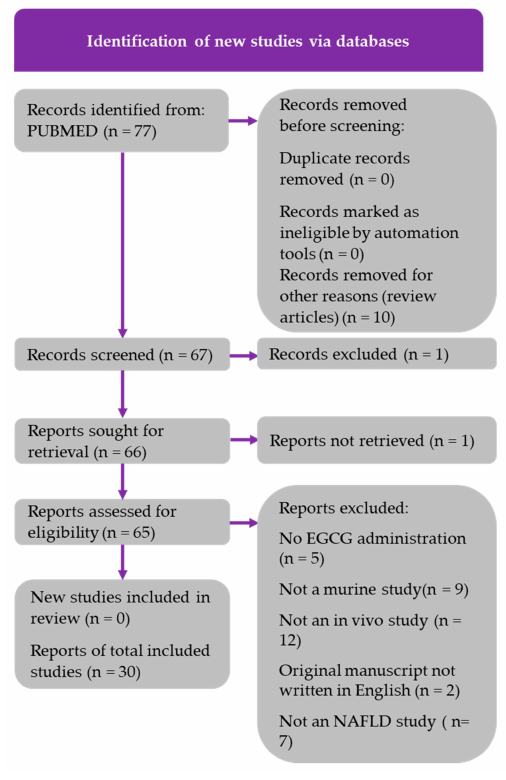
Figure 1. PRISMA flow chart for murine studies, indicating how the 30 studies were chosen.